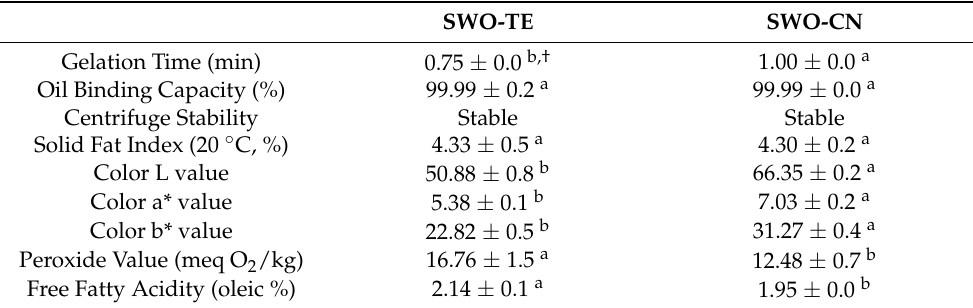
Table 1. The physico-chemical properties of the prepared thyme and cumin-flavored virgin olive oil-sunflower wax